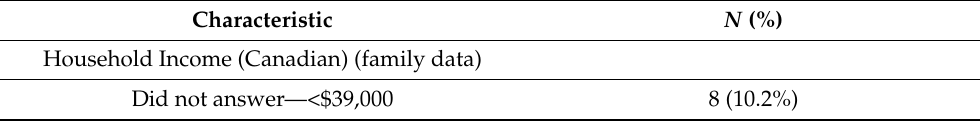
Table 1. Characteristics of families ( n = 78) participating in Guelph Family Health Study pilot studies at